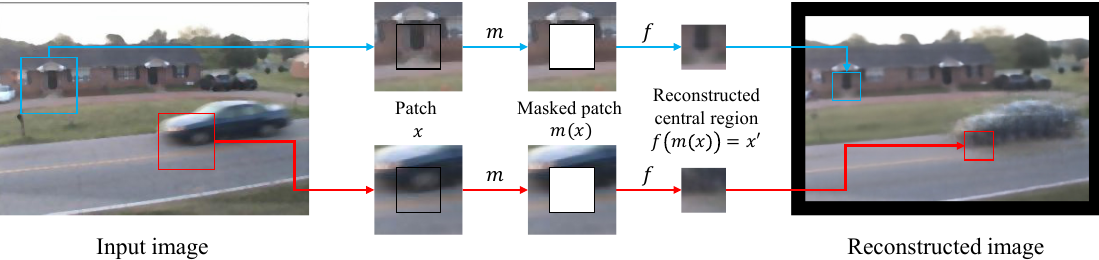
Figure 2. Examples of a reconstruction procedure by our image-completion network. m is a function for masking patch images and f is a function for our image-completion. In Figure 2, the moving car is not included in background images used for training our image-completion network. The image-completion network learns how to reconstruct central regions using only background images. Red and blue lines represent reconstruction of a foreground region and a background region, respectively. The background region is reconstructed from a region surrounding the masked central region. A car wheel in the foreground region is not reconstructed in the red line path. The image-completion network cannot use color and texture of the car wheel. Therefore, errors in the car wheel are